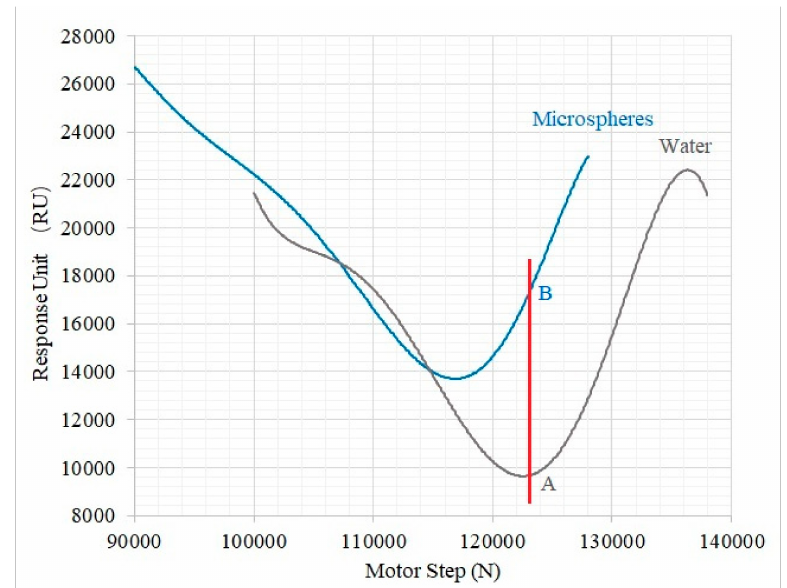
Figure 4. SPR peak curves of fluorescent microspheres and Mili-Q water by angular